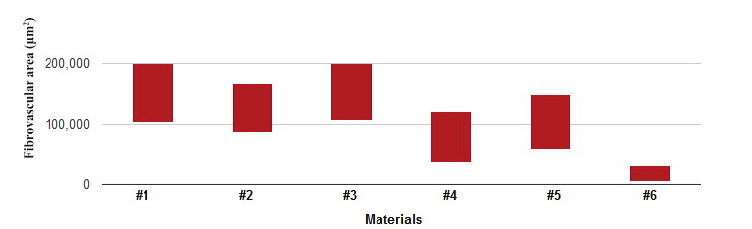
Figure 3. Bar chart of the mean areas of fibrovascular tissue represented in materials #1 to #6, displaying high values for materials #1 and #3 and low values for materials #4 and